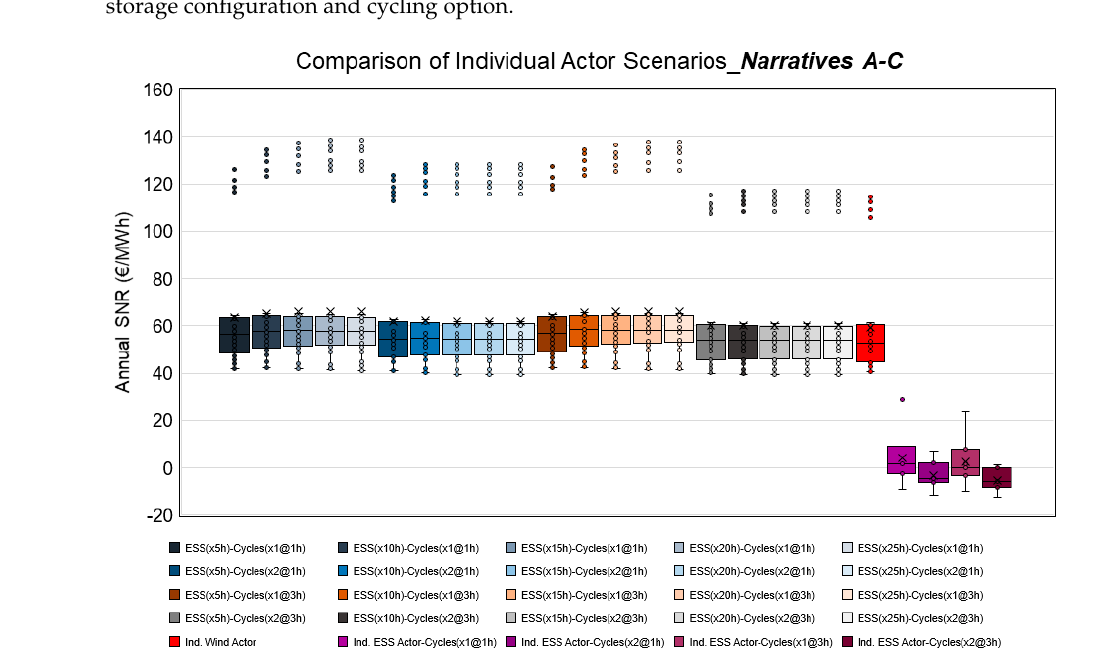
Figure 15. Annual SNR for individual wind-storage actors per different storage configuration and cycling option against the annual SNR of individual wind and individual storage actors.